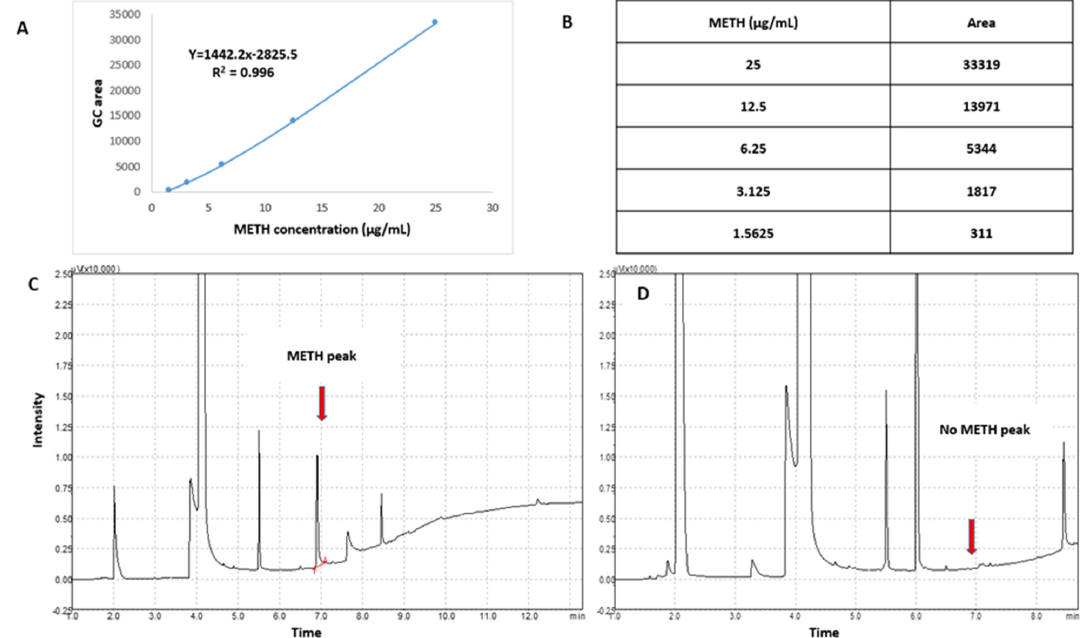
Figure 3. Monitoring of reaction between METH and (KG) 5 by GC. ( A ) METH standard calibration curve, ( B ) METH concentration levels for the calibration curve, ( C ) METH peak before reaction with (KG) 5 , and ( D ) disappearance of METH peak after reaction with (KG) 5 .